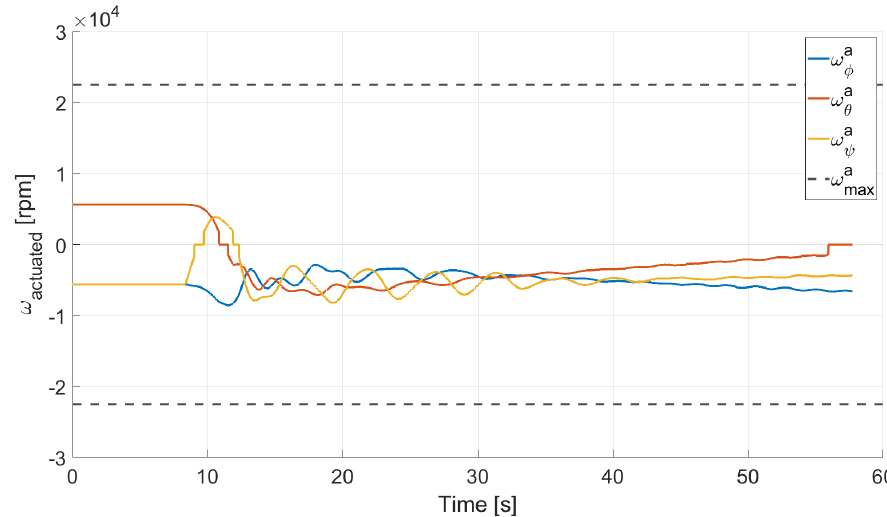
Figure 16. Case 1: RW actuated angular rate.